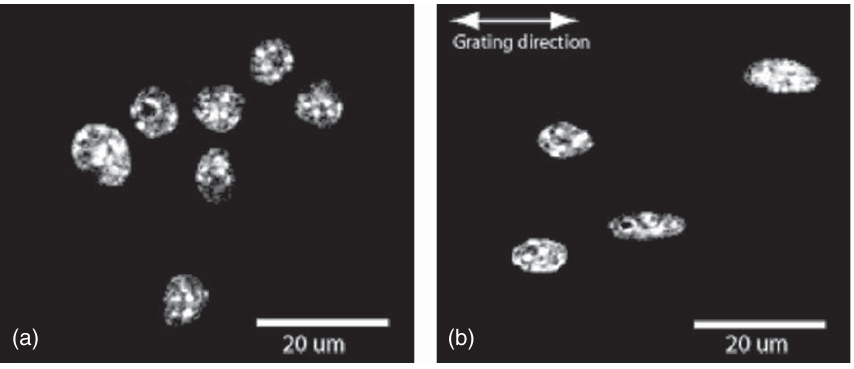
Fig. 10. Fluorescence microscopy images of DAPI stained murine macrophage cell nuclei in planar control configuration (a) and on 2- (cid:1) m PDMS grating (b). Elongation of nuclei along the direction of the grating is clear compared to planar controls Taken from